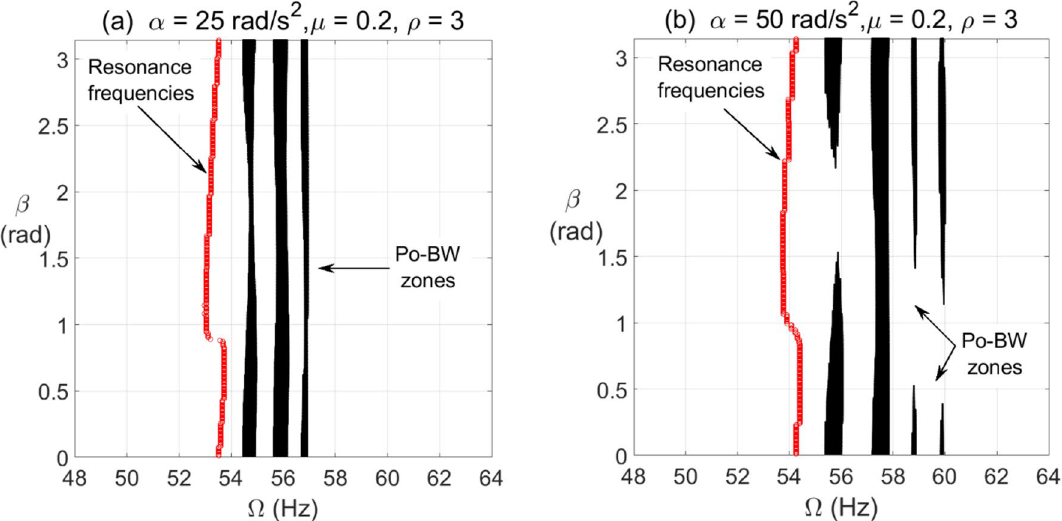
Figure 5. Po-BW zones of rotational speeds at varying unbalance force vector angle of overhung cracked rotor 2 2 system in ( a ) at α = 25 rad/s and in ( b ) at α = 50 rad/s for µ = 0.2 and ρ = 3 .